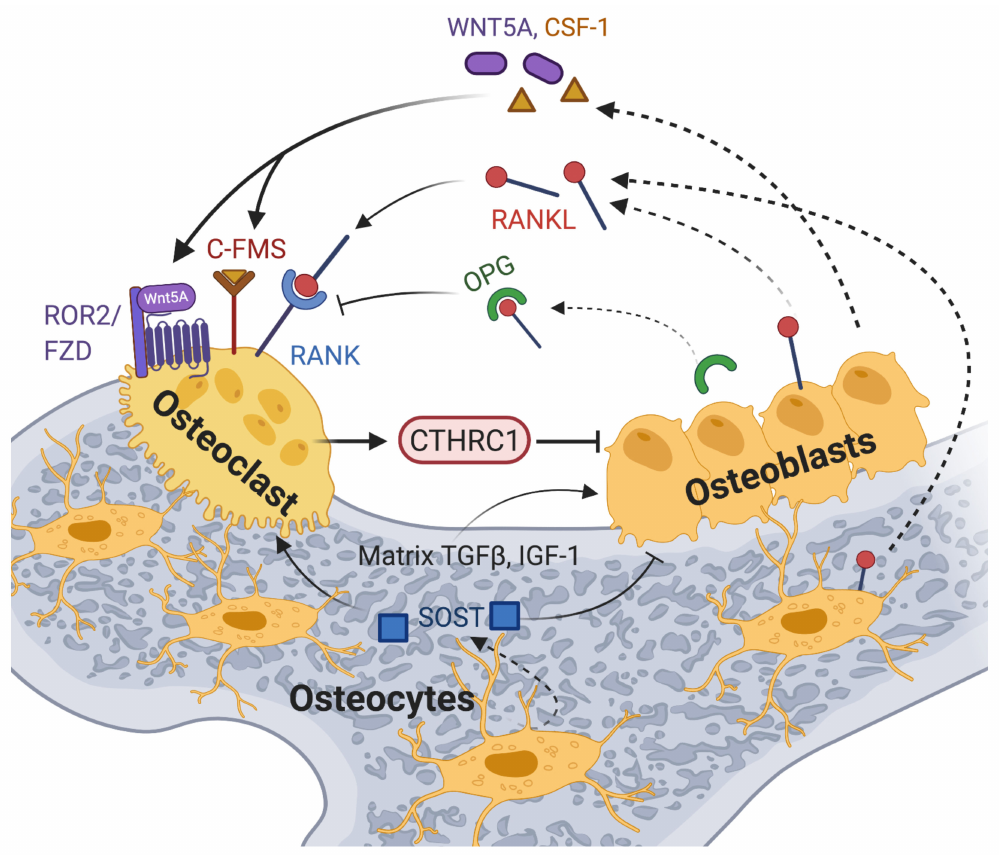
Figure 5. A model of CTHRC1 action in osteoclast–osteoblast crosstalk is shown, highlighting the effects of some of the key players involved. Membrane-bound and soluble RANKL produced by cells of the osteoblast lineage and by immune cells induces osteoclastogenesis upon binding to the receptor RANK on osteoclast precursors. RANKL action is opposed by the decoy receptor OPG secreted by osteoblasts or osteocytes. The inflammatory bone environment in RA results in increased production of RANKL by immune cells, osteoblastic cells and synovial fibroblasts. This exacerbates osteoclast differentiation and bone erosion. WNT5A binds to ROR2 receptors and activates non-canonical signaling, thereby promoting osteoclast differentiation and bone resorption. Likewise, signals generated by the binding of stromal-cell-produced colony- stimulating factor 1 (CSF-1) to the C-FMS receptor promote osteoclast differentiation and osteoclastogenesis. TGF- β and other factors, including IGF-1 released from the bone matrix during bone resorption, stimulate osteoblastogenesis [81]. CTHRC1 expression and secretion by osteoclasts points to an autoregulatory mechanism promoting osteoblastogenesis for enhanced bone formation [10,11,82,83], potentially by activating noncanonical Wnt signaling through the co-receptor WAIF1/5T4 [15,83]. An alternative model proposed by Jin et al. implicates osteoblast- and osteocyte-secreted CTHRC1 in the negative regulation of osteoclast differentiation through inhibition of RANKL-RANK signaling [84]. Created with